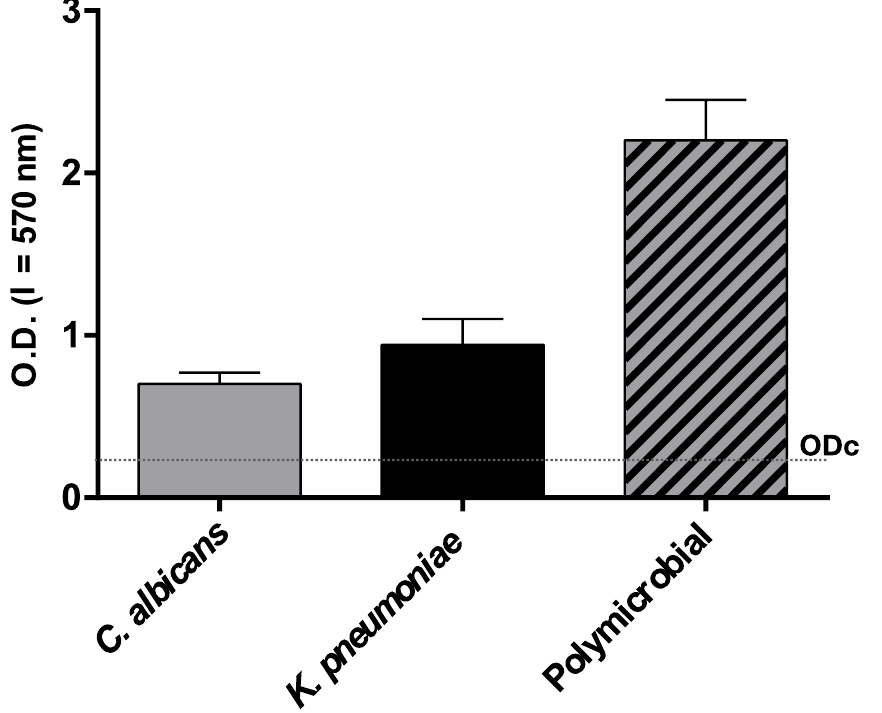
Figure 1. Biomass in mono- (K. pneumoniae and C. albicans) and polymicrobial biofilms ( n = 3, mean ± SD) quantified by crystal violet staining and expressed as OD 570 . The dotted line corresponds to ODc, that is the cut-off value, defined as three standard deviations above the mean OD of the negative control. Negative (OD ≤ ODc), weak (ODc ≤ OD ≤ 2 ODc), moderate (2 ODc < OD ≤ 4 ODc), and strong biofilm production (4 ODc < OD), according to Stepanovich [22].